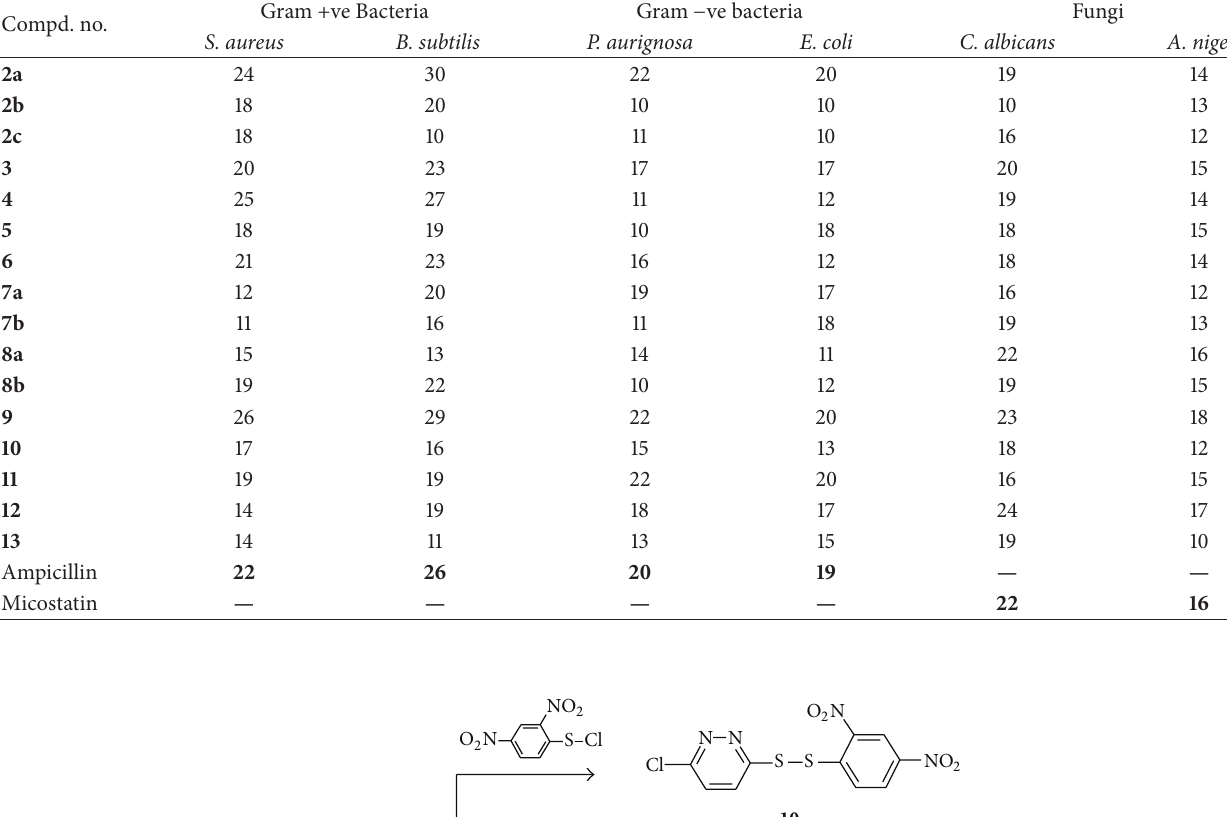
Table 1: Antimicrobial activity of synthetic